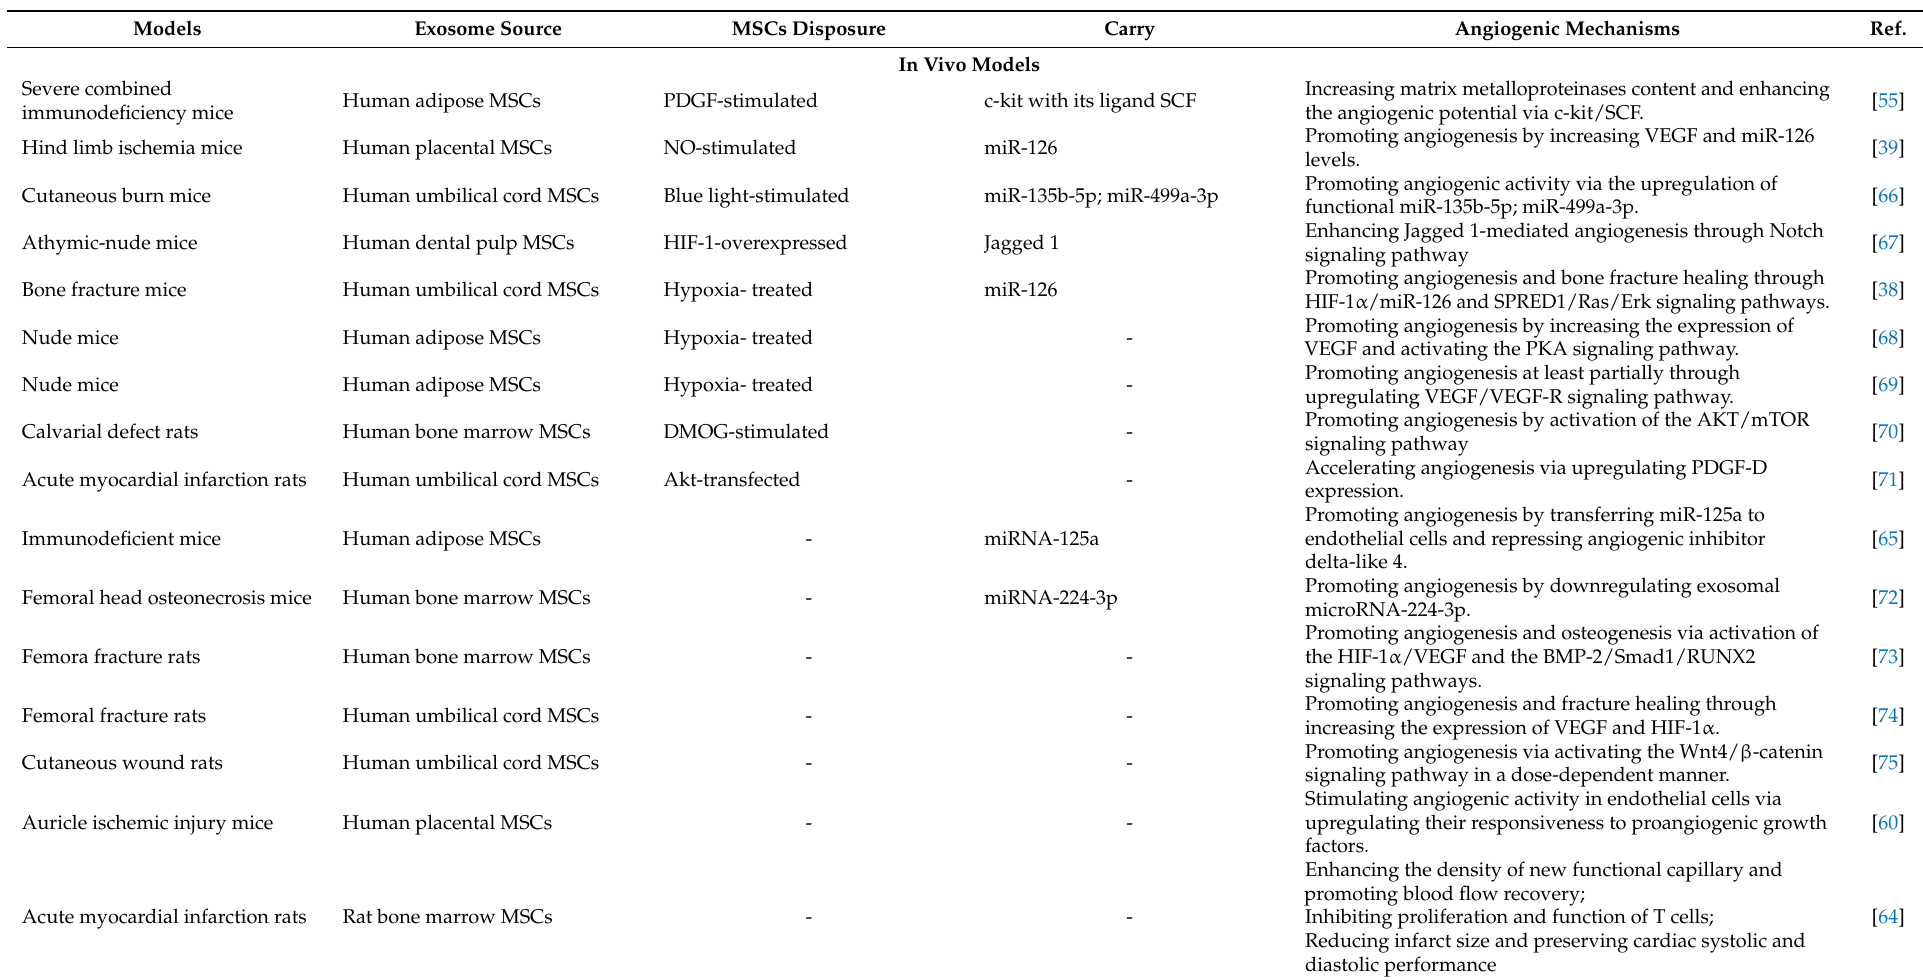
Table 2. MSC Exosomes Facilitate Angiogenesis in Various